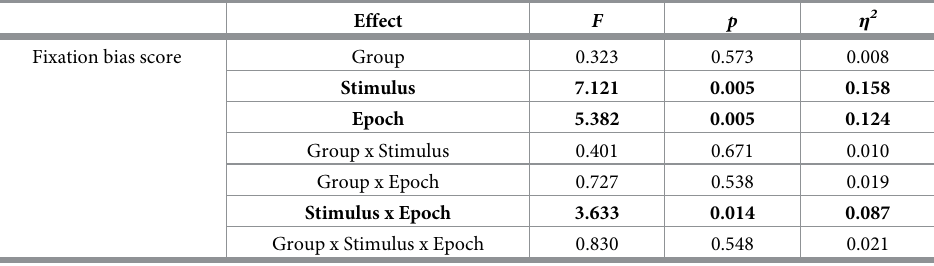
Table 4. Test statistics of the ANOVAs for the effects of group (patients vs. controls), stimulus class (happy vs. angry vs. pain), and epoch (0–500 ms vs. 500–1000 ms vs. 1000–500 ms vs. 1500–2000 ms) on fixation bias scores.